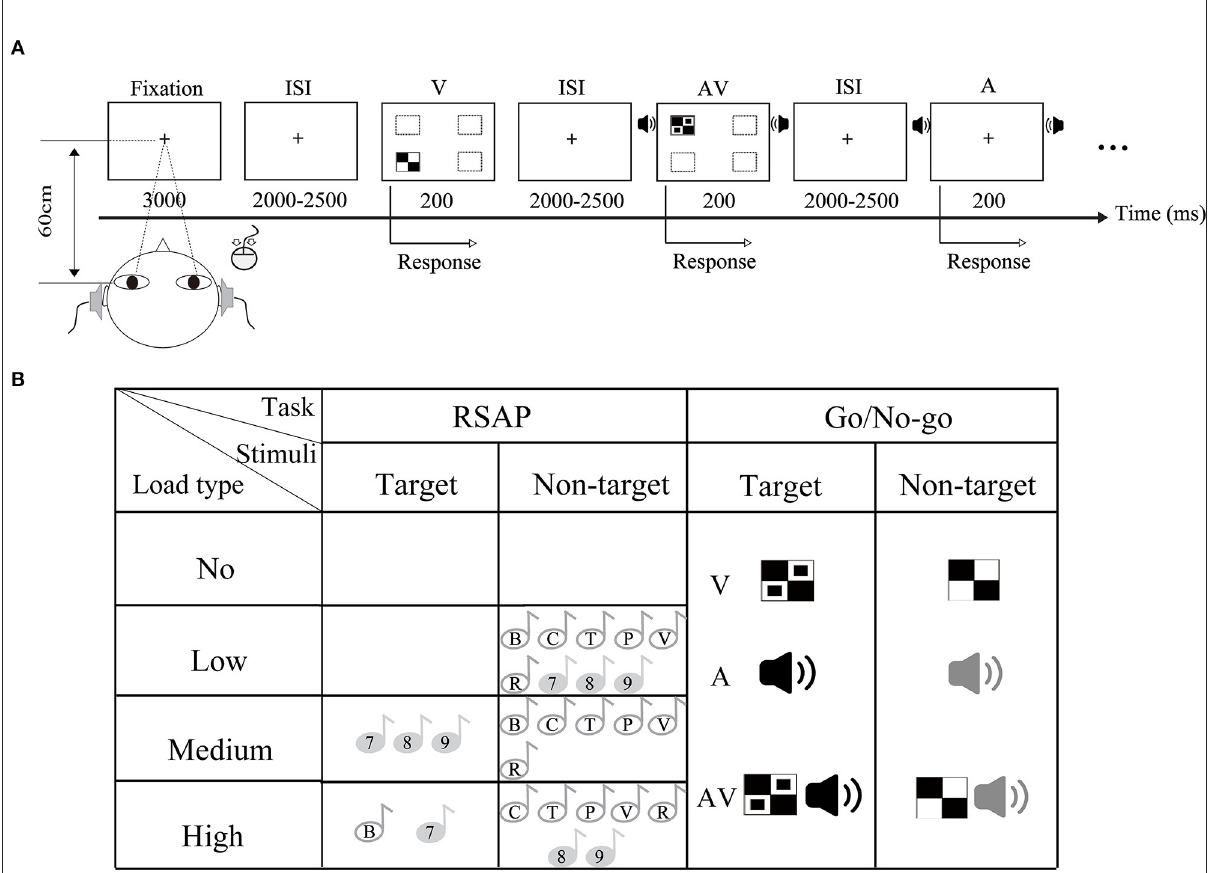
FIGURE1 Schematic illustration of experimental paradigm and material. (A) Stimuli of the Go/No-go task were randomly presented in visual (V), auditory (A), and audiovisual modalities (AV). In this experiment, the RSAP task was purposively controlled to be present. (A) Showed the No_load condition. (B) Representation of the dual task stimuli for the different attentional load conditions. This figure illustrates a load manipulation in which the task